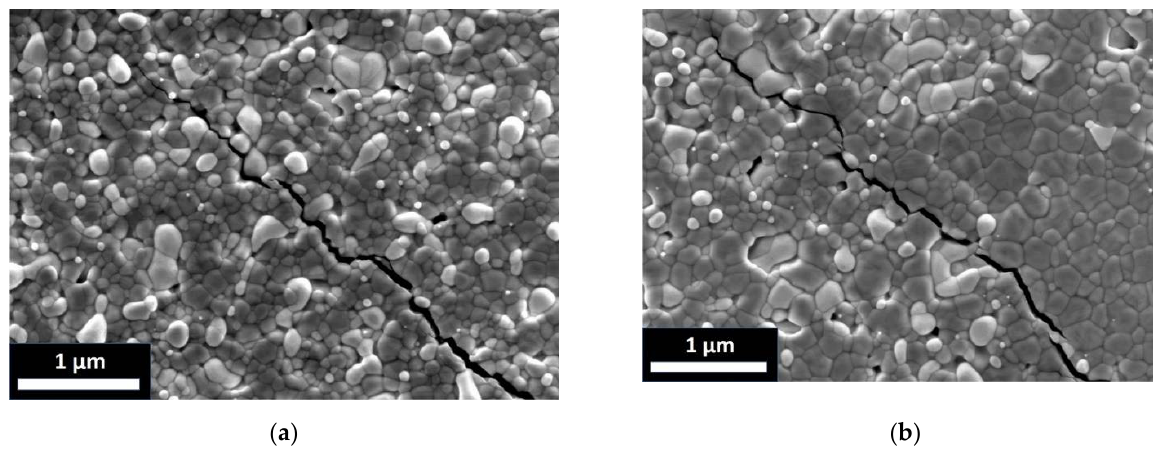
Figure 3. SEM images of thermally etched (1100 °C/1 min H 2 ) TZP-WC composites and crack tip induced by Vickers HV10 indentation. ( a ) Microstructure of 28 WC-1300. ( b ) Microstructure of 28 WC-1400. Bright phase strongly attacked by hydrogen etching corresponds to tungsten carbide and dark matrix phase with grain boundaries revealed corresponds to zirconia.